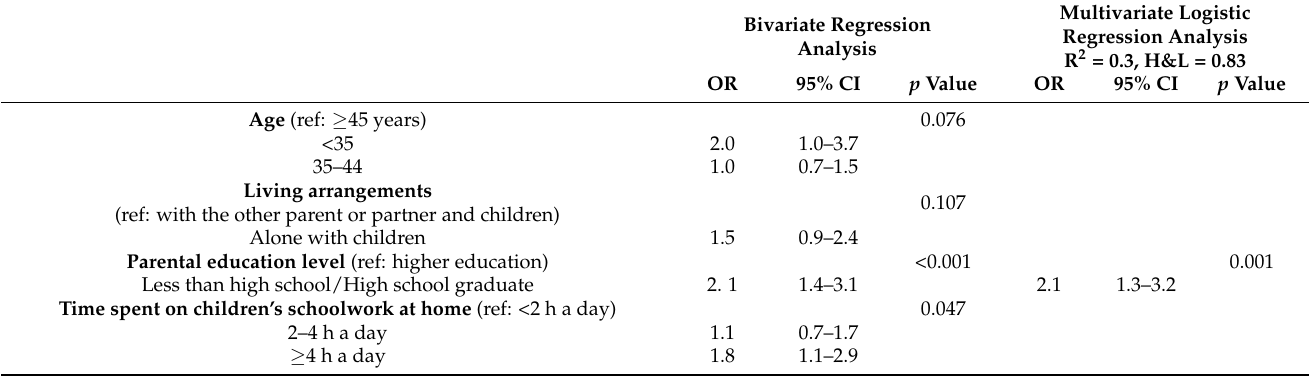
Table 4. Factors associated with moderate to severe parental anxiety levels during the COVID-19 lockdown (N =